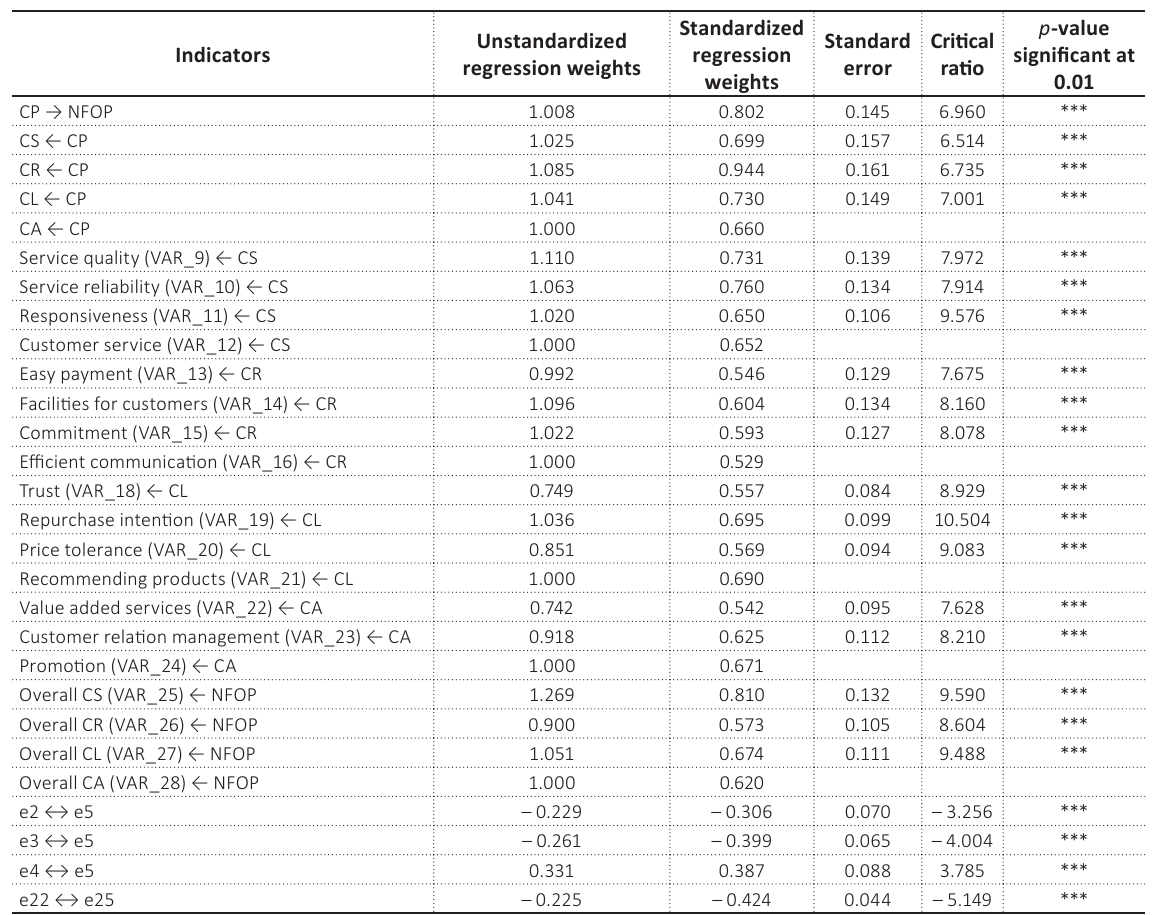
Table 4. Parameter